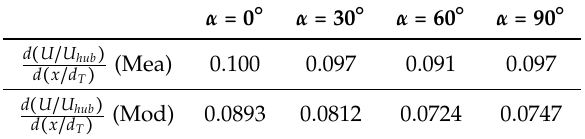
Figure 8. ( a ) normalized stream-wise mean velocity profile, U / U hub along the hub height for various α . The solid lines represent those measured from experiment and the dashed lines are velocities predicted by model from Bastankhah and Porté-Agel [39]; ( b ) determination of k ∗ by fitting the measured and modeled velocities of a traditional turbine without winglet. Table 1. Comparison of measured and modeled d ( U / U hub ) across various pitching d ( x / d T )